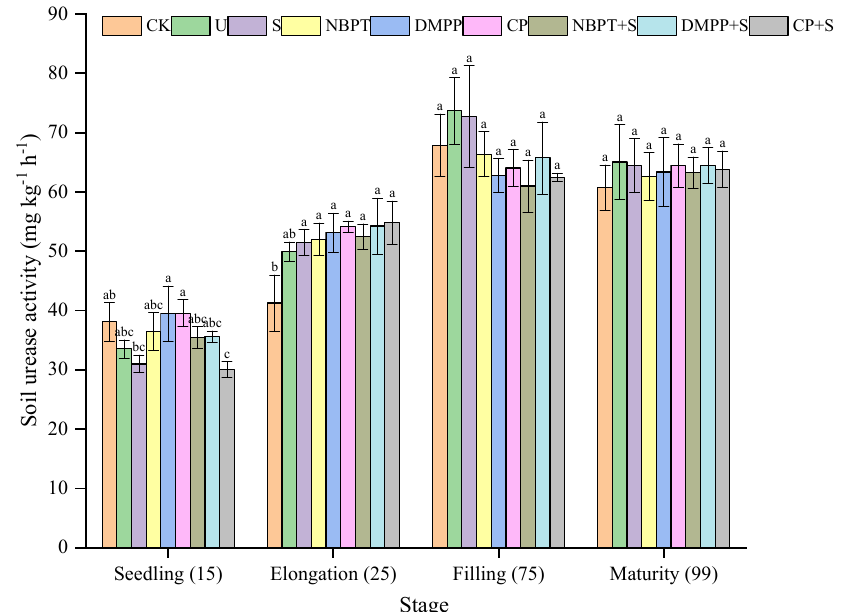
Figure 2. Soil urease activity of different treatments. Different letters indicate significant differences between different treatments at p < 0.05 by Tukey test.